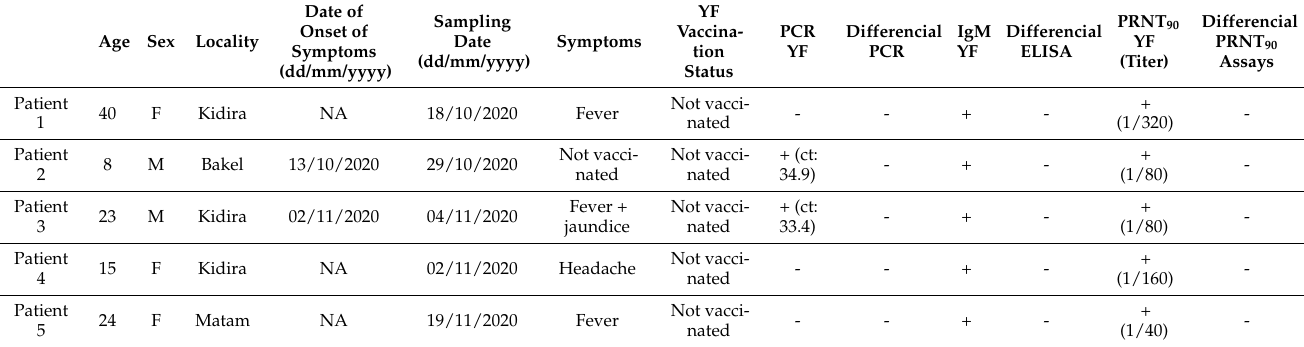
Table 1. Summary of the first Yellow Fever cases detected in Tambacounda and Matam. (ct: threshold cycle).